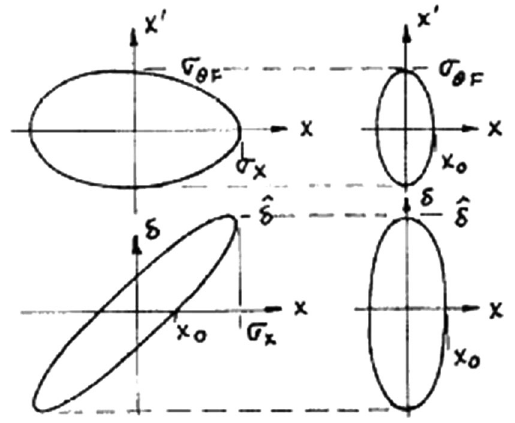
FIG. 5. Illustration of how the horizontal phase space can be twisted along the bunch ’ s axial direction.